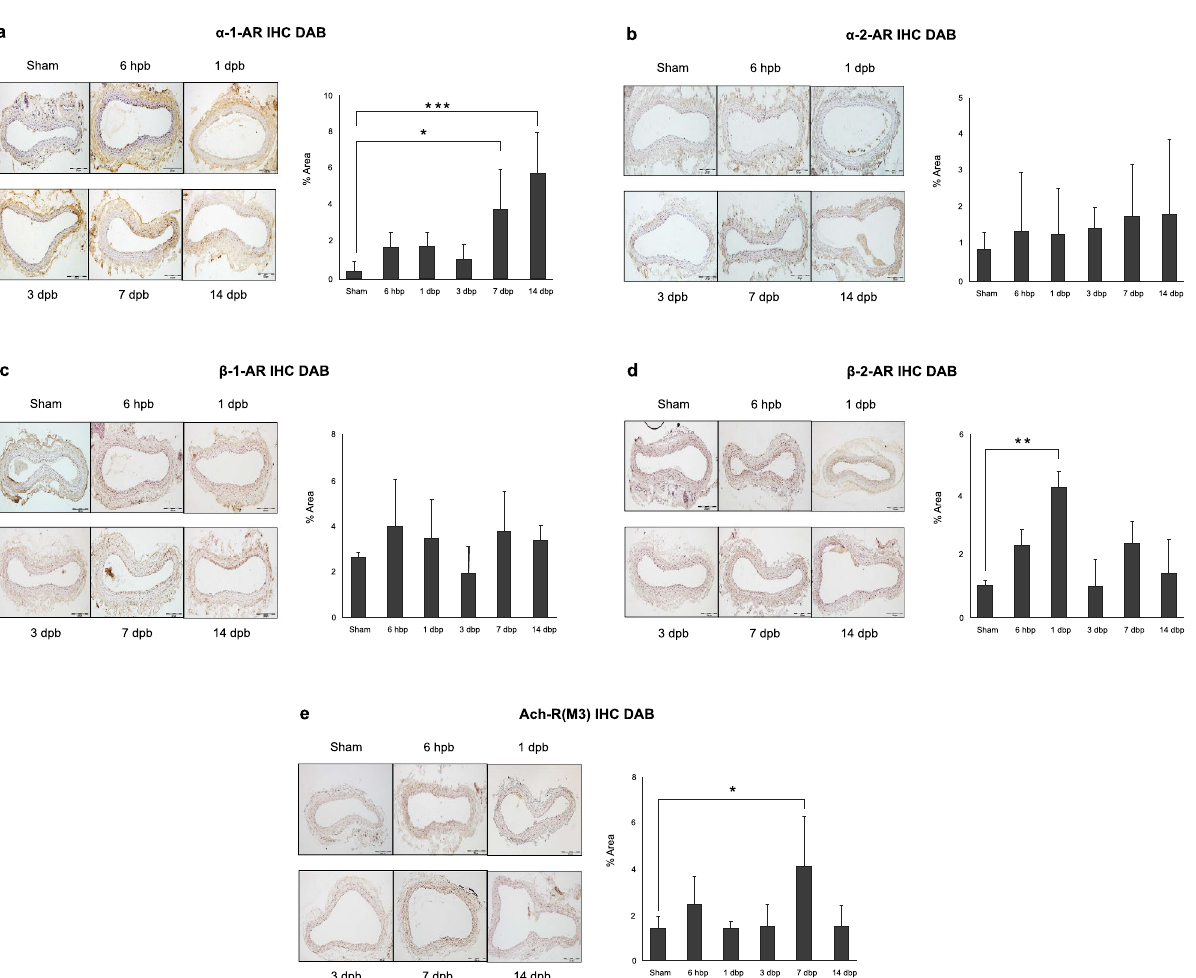
Figure 4. Immunohistochemistry staining and quantification of positive stained expressions of ( a ) α-1a adrenergic receptor (AR), ( b ) α-2a-AR, ( c ) β-1-AR, ( d ) β-2-AR and ( e ) muscarinic acetylcholine M3 receptor in rat carotid artery rings after burn. One-way ANOVA with Bonferroni t-tests was applied Data were presented as mean ± SD. * p < 0.05, ** p < 0.01, *** p <